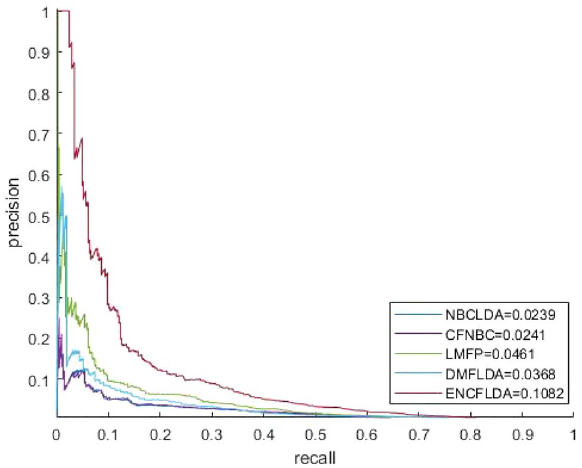
Figure 2. AUPR comparison between ENCFLDA model and other advanced models based on the same data set.